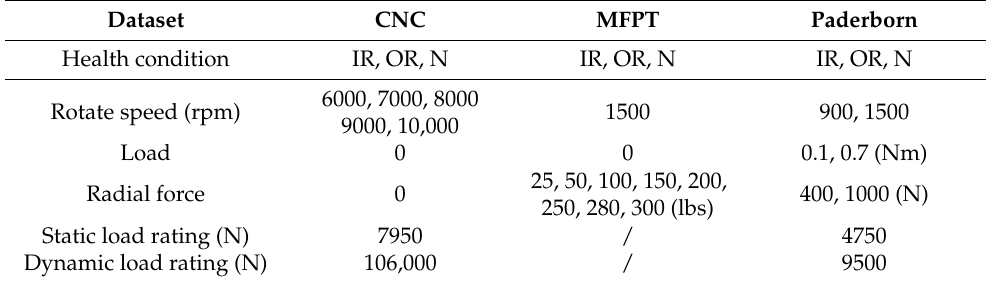
Table 2. Description of the three datasets.